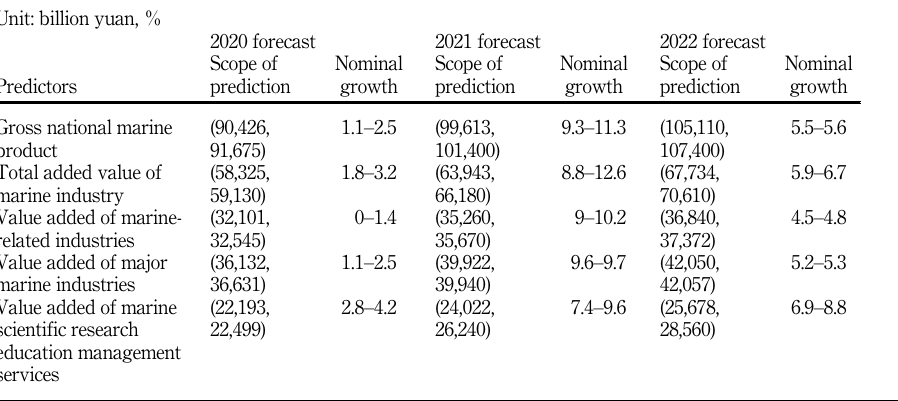
Table 4. Forecast of